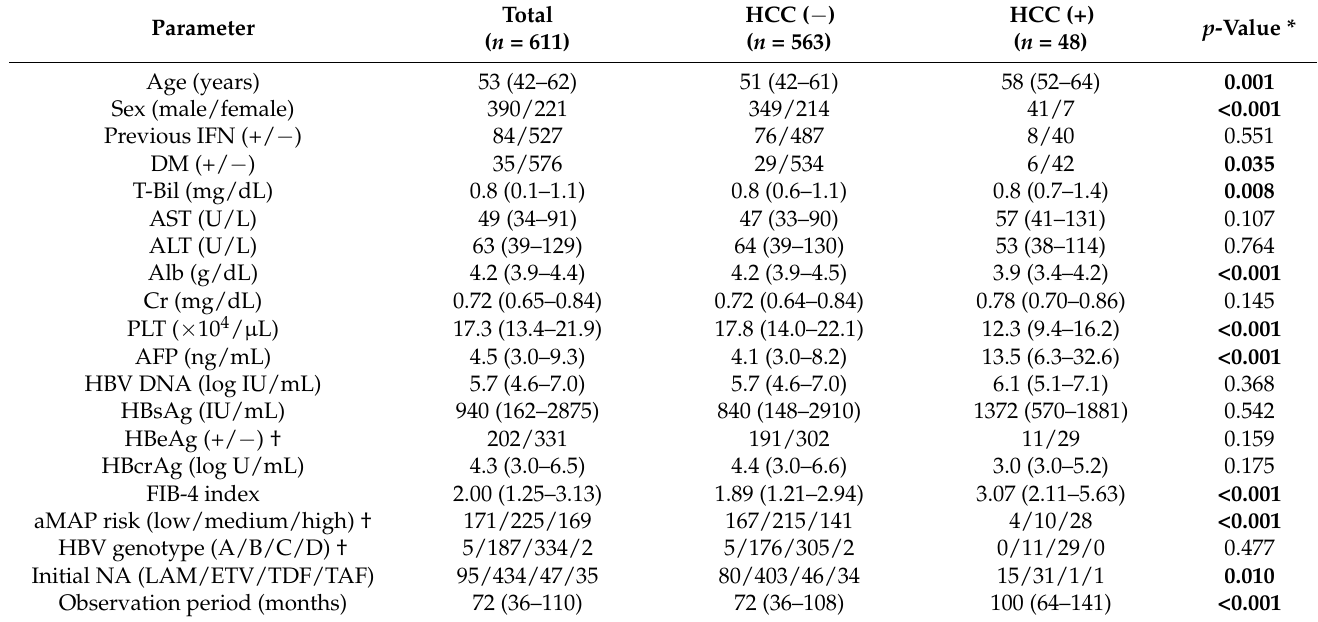
Table 1. Baseline clinical characteristics of patients with chronic HBV infection at the start of NA